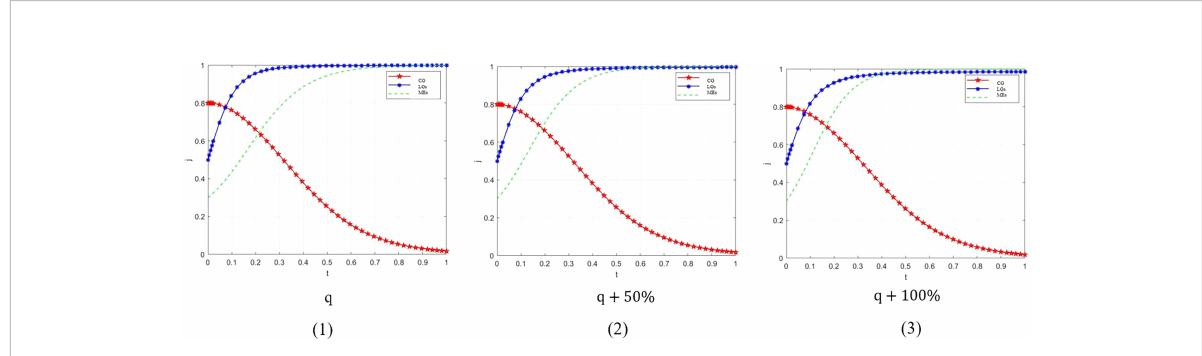
FIGURE 7 The impact of LGs ’ incentives on the